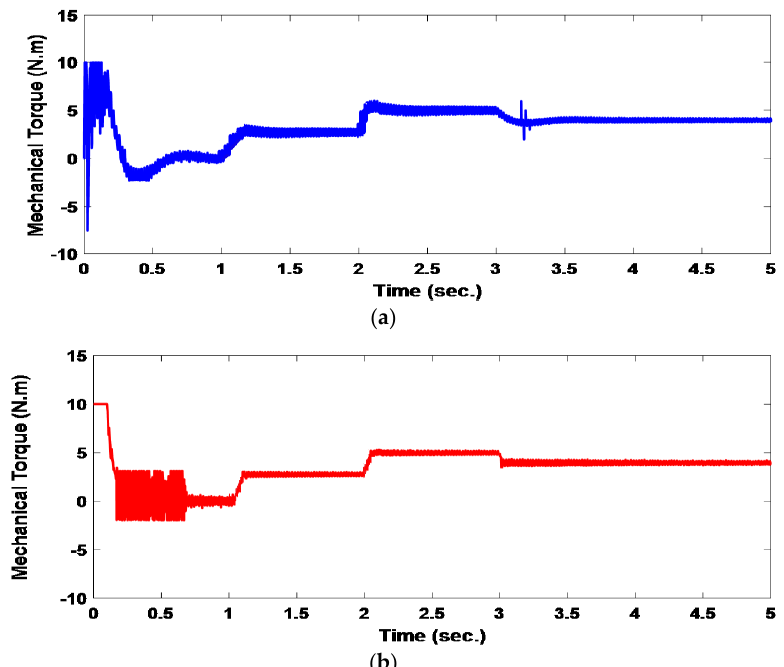
Figure 21. The motor-developed torque for the desired speed, 50 rad/s, for ( a ) fuzzy PID based PSO and ( b ) fuzzy-PID-based C-BO.